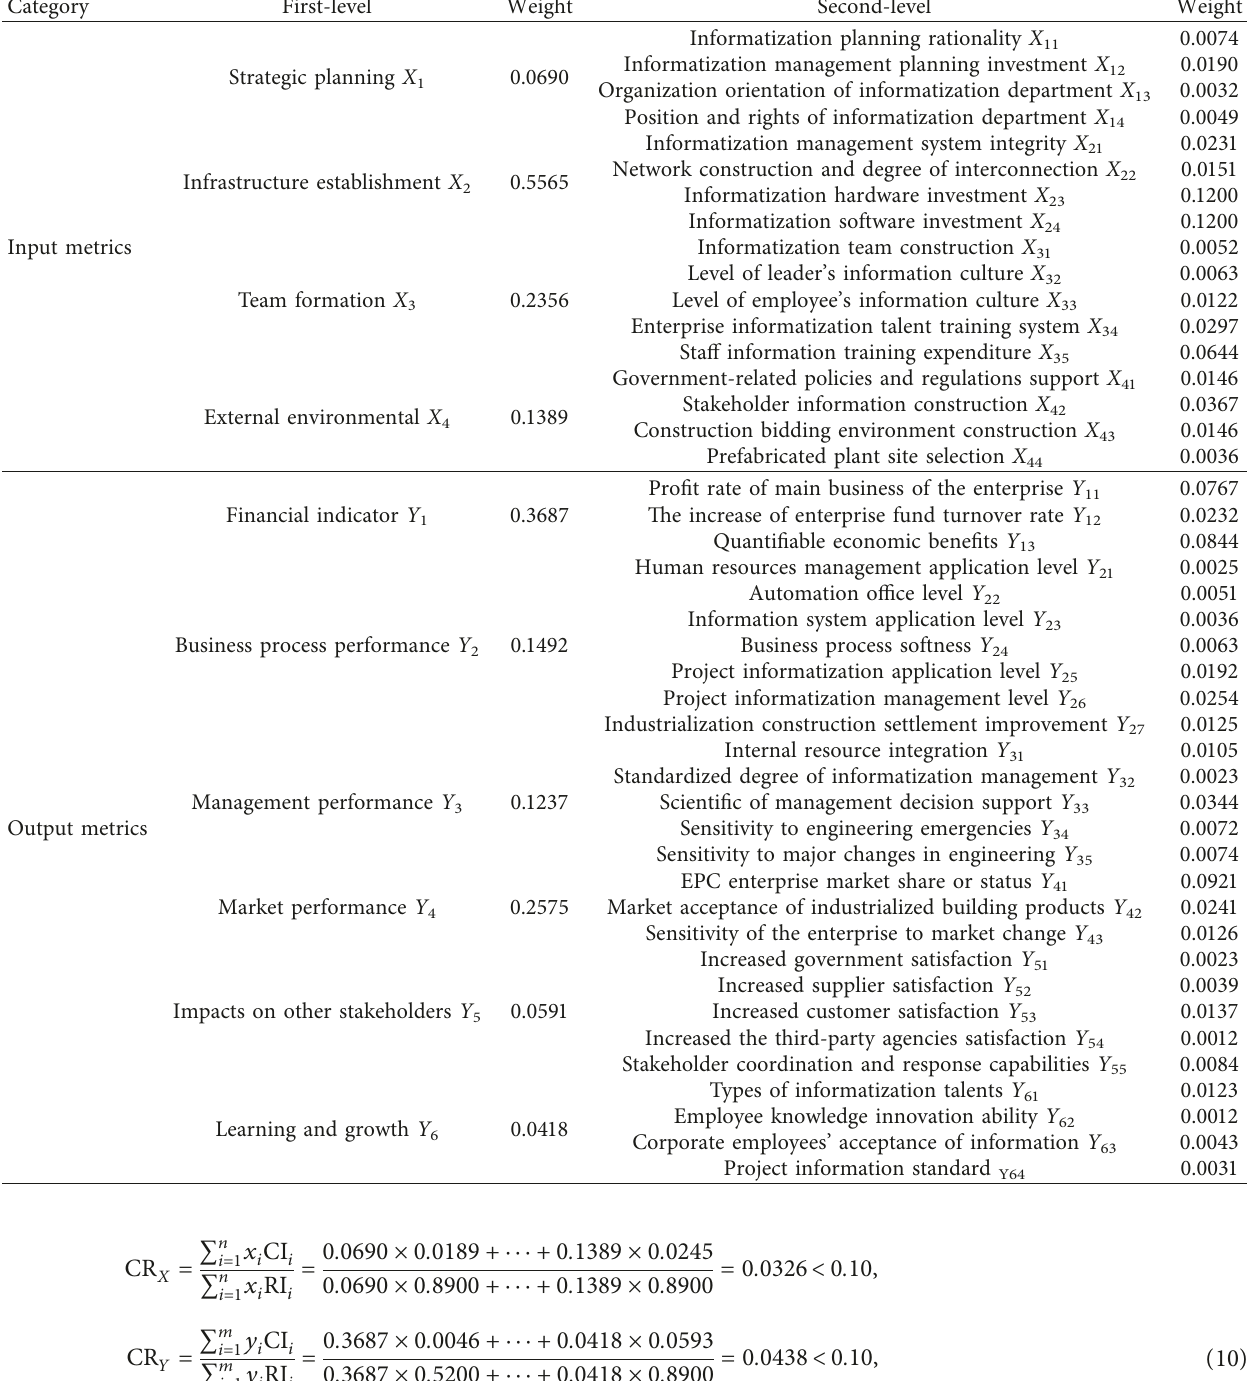
Table 4: Weight index of the evaluation index for construction industrialization